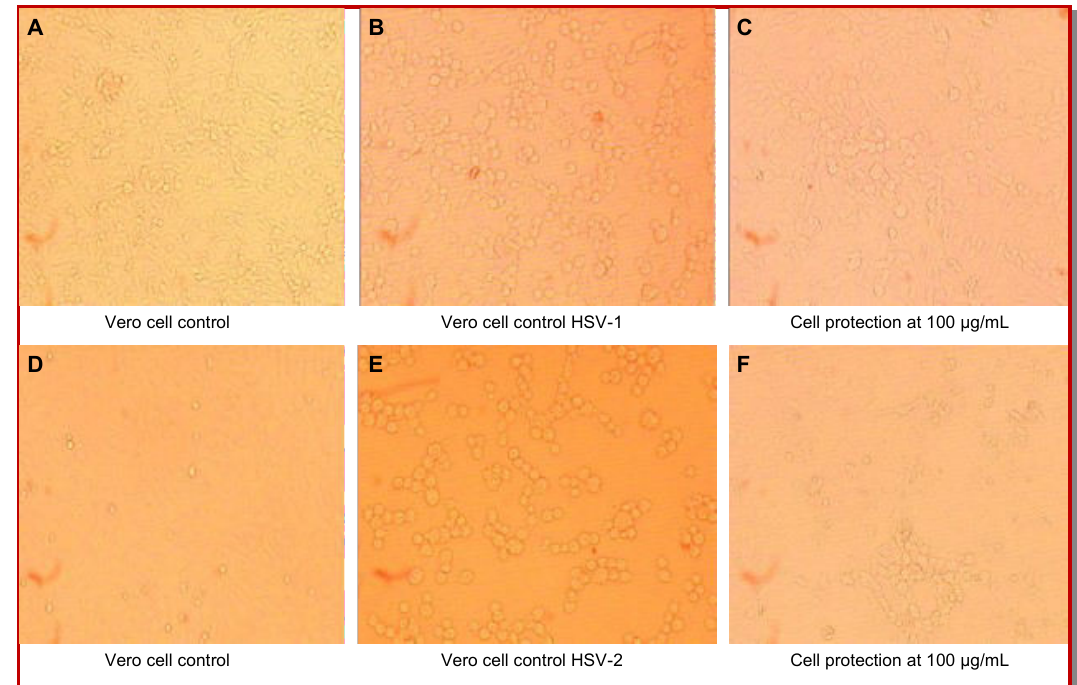
Figure 3: Antiviral activity of BanLec against HSV-I (A-C) and HSV-2 (D-F) and its morphological changes in the Vero cells were examined under a phase contrast